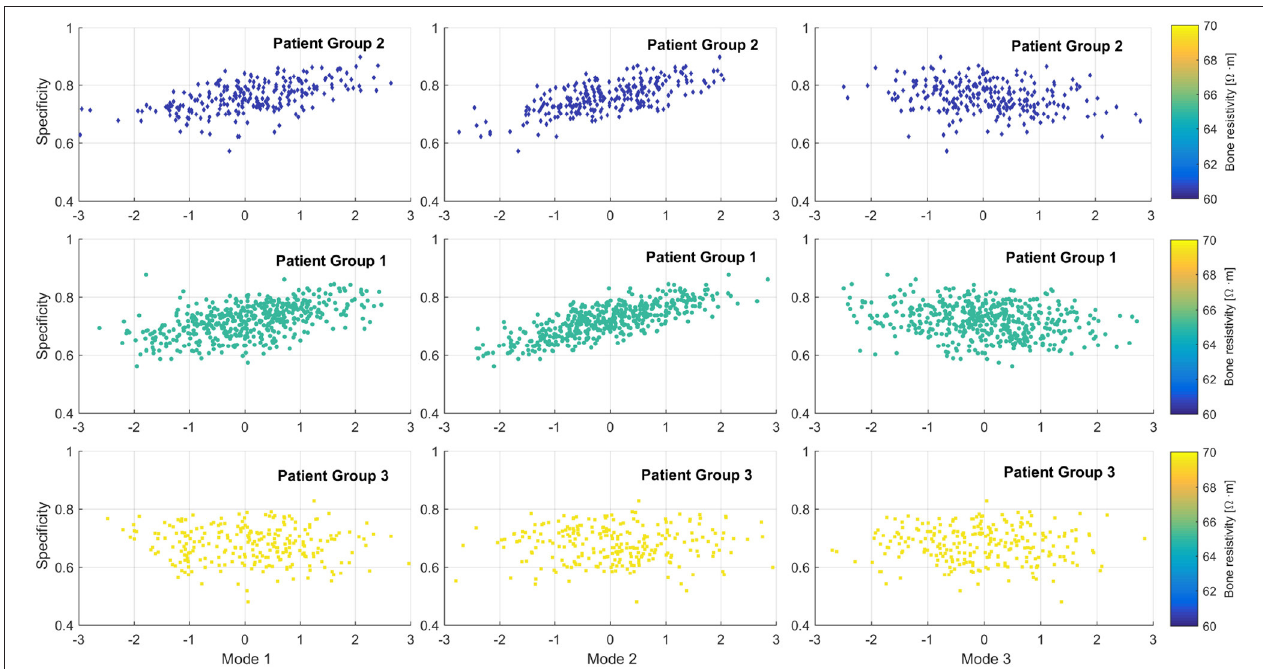
FIGURE 6 | Effect of the cochlear morphology on implant global performance of a population of virtual patients. From left to right, first to third mode of variation. From top to bottom, from low to high bone resistivity